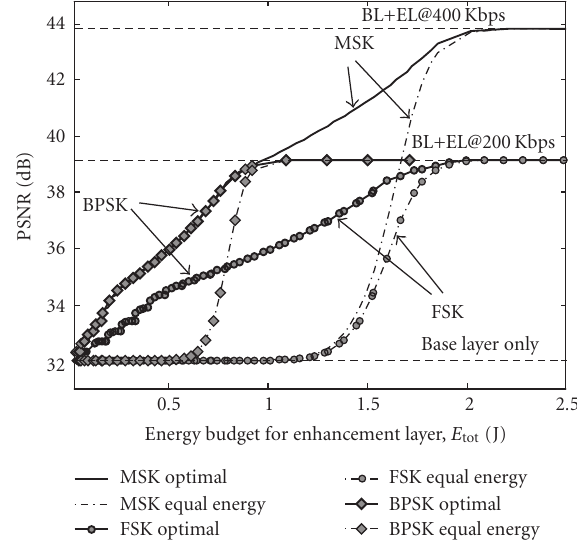
Figure 9: Performance comparison between the proposed ap- proach and equal energy distribution (BPSK modulation, RS(160,100), B T = 200KHz). Incremental PSNR contribution for each received packet beyond the BL is represented.